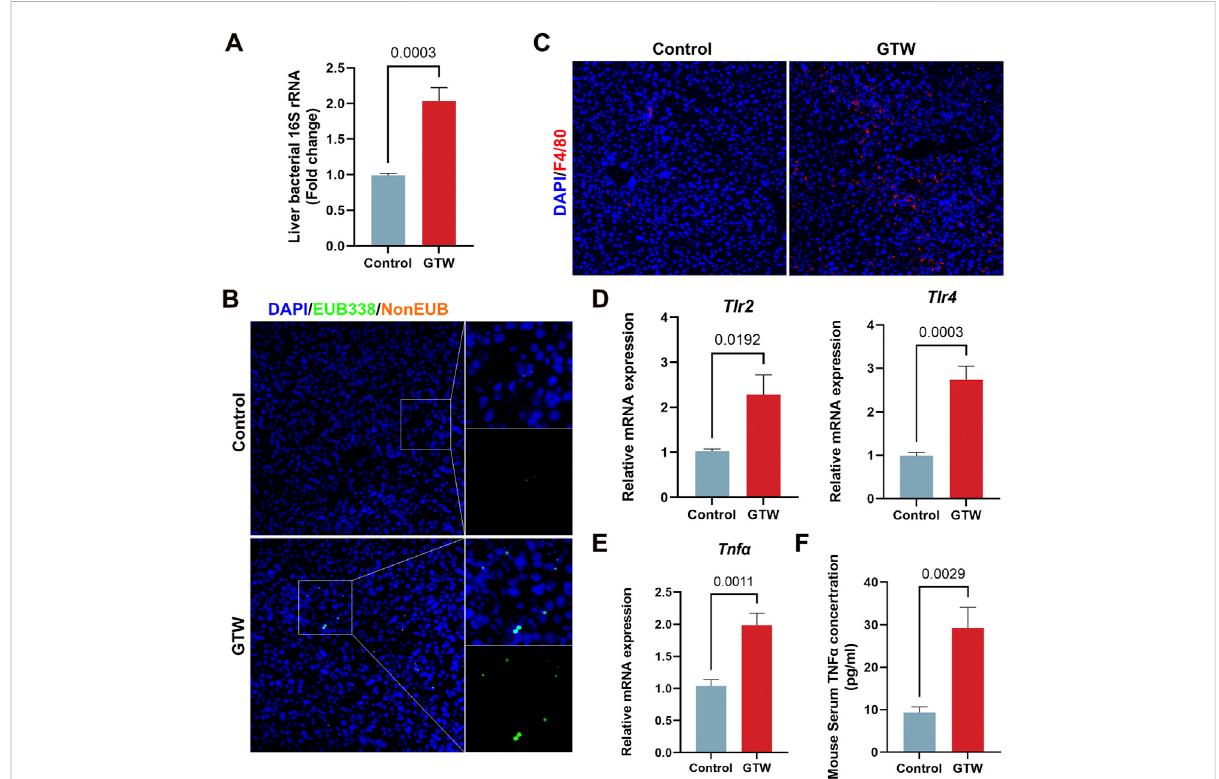
FIGURE 7 GTW administration promoted bacterial translocation to the liver and triggered hepatic in fl ammation. (A) Liver bacterial 16S rRNA expression measuredbyRT-PCR( n =6). (B) Bacteriadetected intheliverusingFISHwithprobesEUB338targetingeubacteria16SrRNAregion(20x).Thenuclei were stained with DAPI (blue) and bacteria stained with EUB338 (green). (C) Representative images of immuno fl uorescent staining of F4/80 (red) in liver(20x).DAPIwasusedtovisualizenuclei(blue). (D) HepaticTLR2andTLR4mRNAexpressionlevelsweredetectedbyRT-PCR( n =6). (E) The expression levels of proin fl ammatory cytokine TNF α in liver were measured using RT-PCR analysis ( n = 6). (F) Serum TNF α concentration in GTW- treated mice were detected by ELISA ( n = 6). Data are presented as mean ± SEM. p < 0.05 was considered statistically signi fi